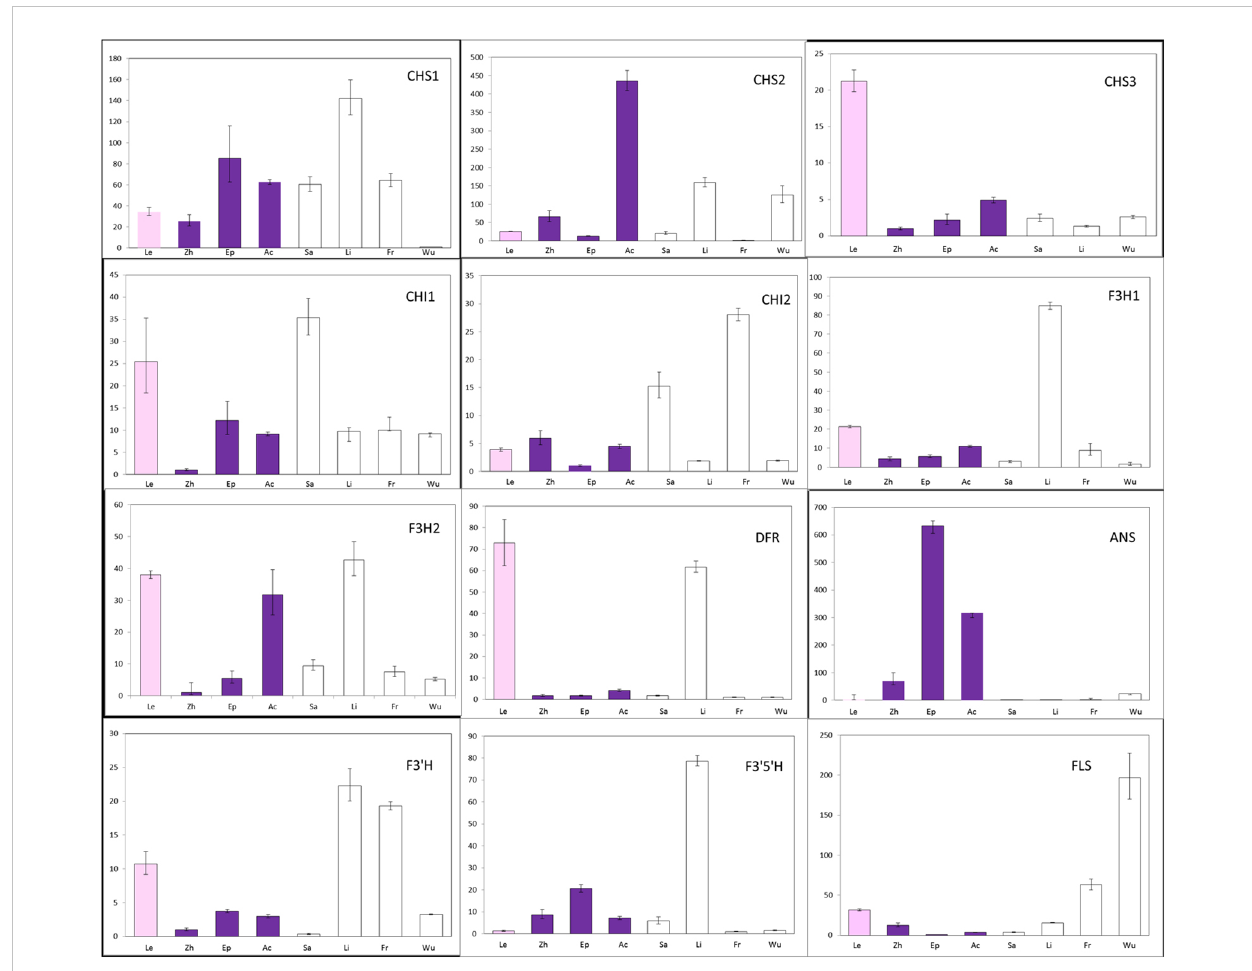
FIGURE 4 Quantitative expression pattern of ABP structural genes from petal tissue of eight Epimedium species. Colored and empty bars represent A+ and A- species, respectively. Le, Zh, Ep, Ac, Sa, Li, Fr and Wu represent E. leptorrhizum , E. zhushanense, E. epstenii , E.acuminatum , E. sagittatum , E. lishihchenii, E. franchetii and E. wushanense . Data presented here are the mean values of three replicates with error bars indicating